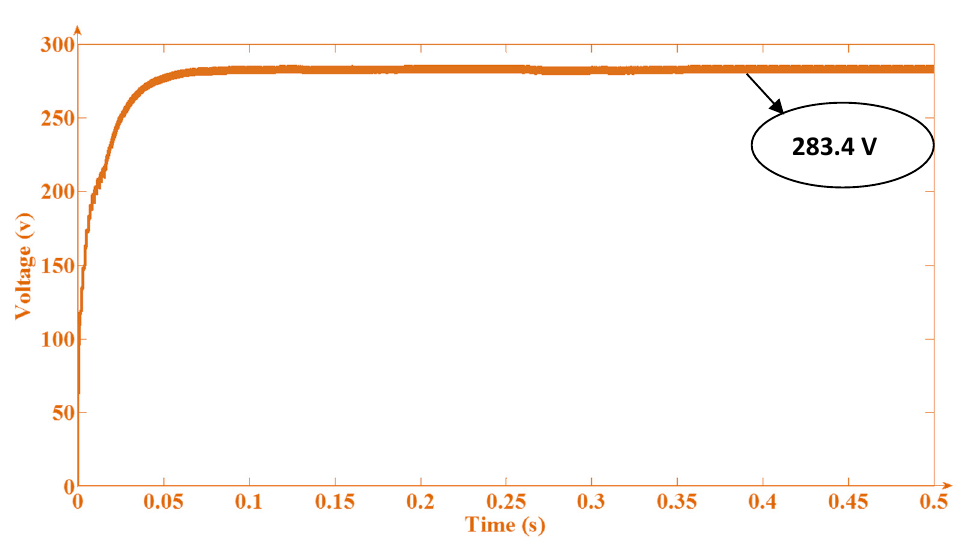
Figure 39. Nine level output voltage waveform for MLI interfaced with PI based BDC.